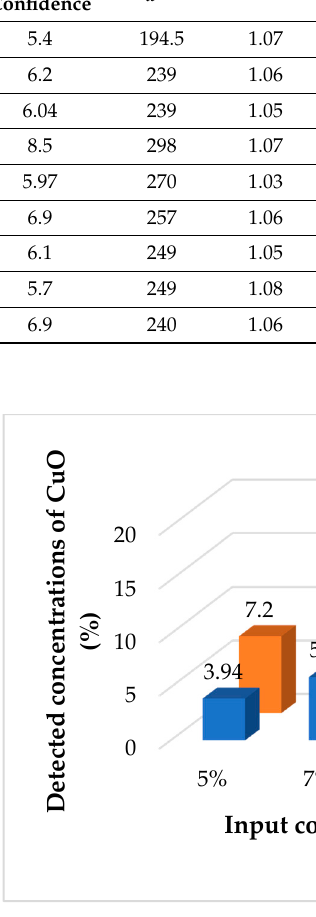
Table 3. Results of the measurement of fiber diameters and calculation of uniformity coefficients. Sample Rotating Needle Cylinder